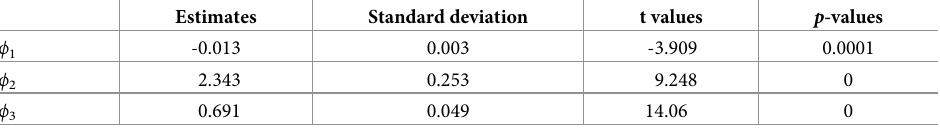
Table 3. Signification analysis of the regression model for the mass loss according to the pH for each PDLGA poly- mer ( R 2 =